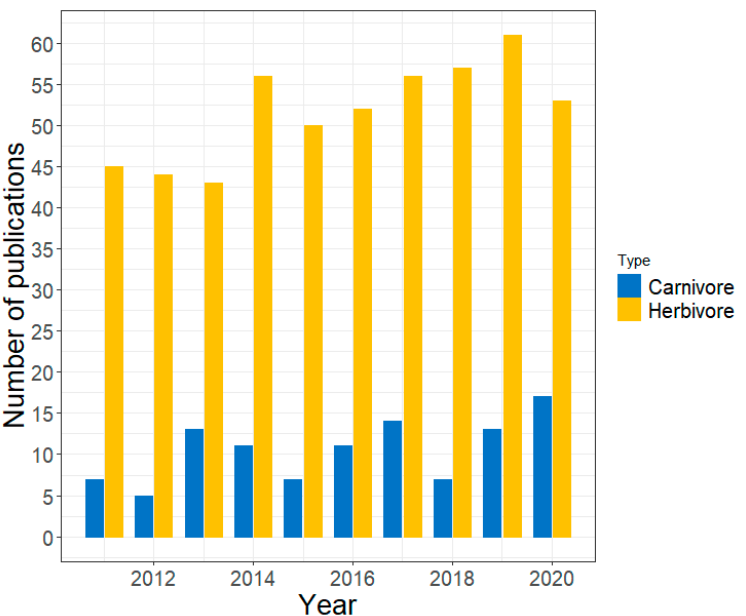
Figure 1. Annual frequency of publications relating to bush encroachment and large African carnivores for a recent 10-year period (2011–2020). Publications related to bush encroachment and herbivores are included for comparison. Search conducted in Google Scholar in March 2022.